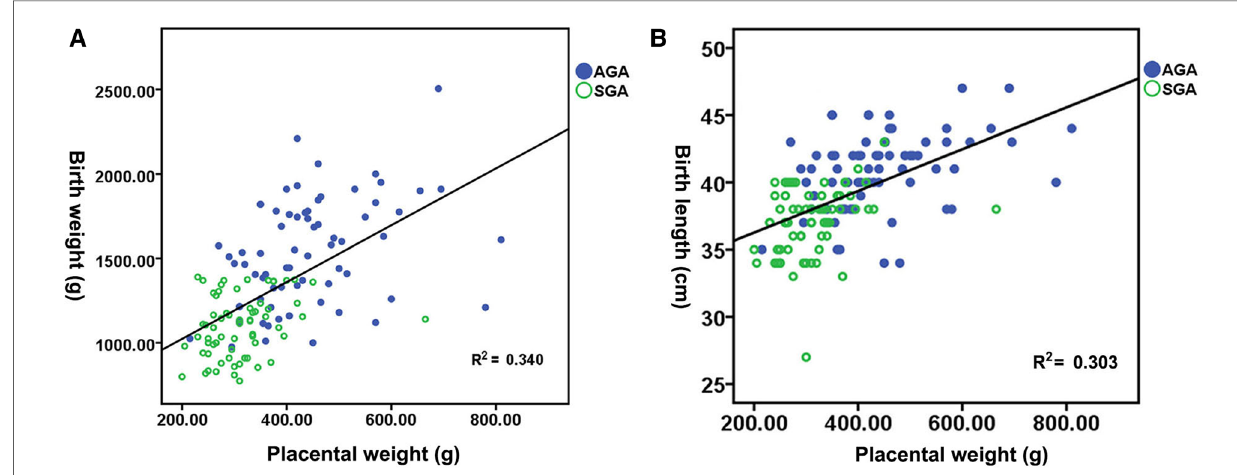
FIGURE 1 Distribution of birth weight (A) and length (B) in accordance with placental weight.